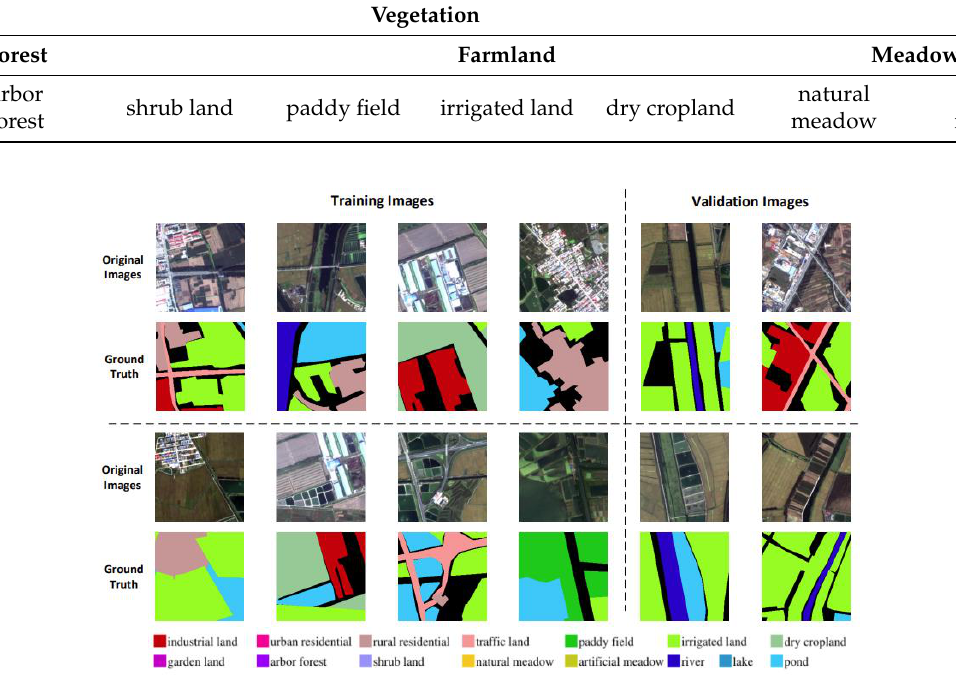
Figure 5. Sample images of training and validation images in the GID dataset. Table 1. The 8 vegetation subclasses in the GID dataset.